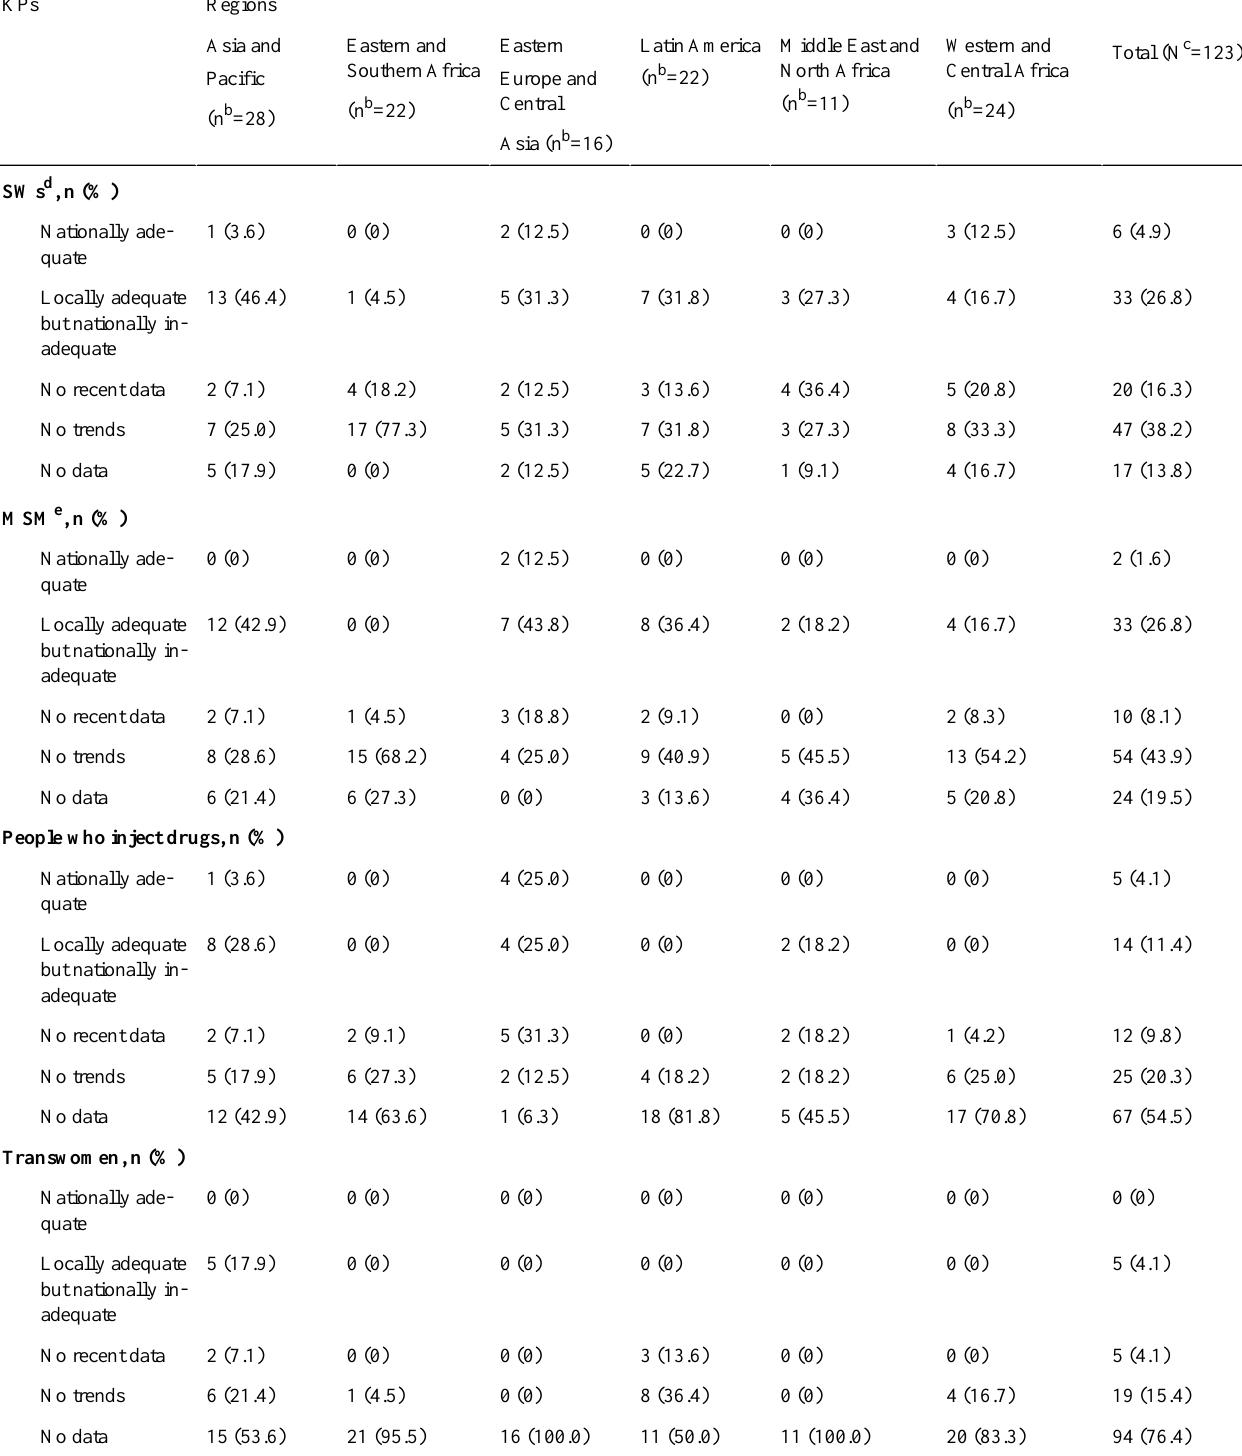
Table 1. Categorization of HIV prevalence data by KP a and region (2001-2017).